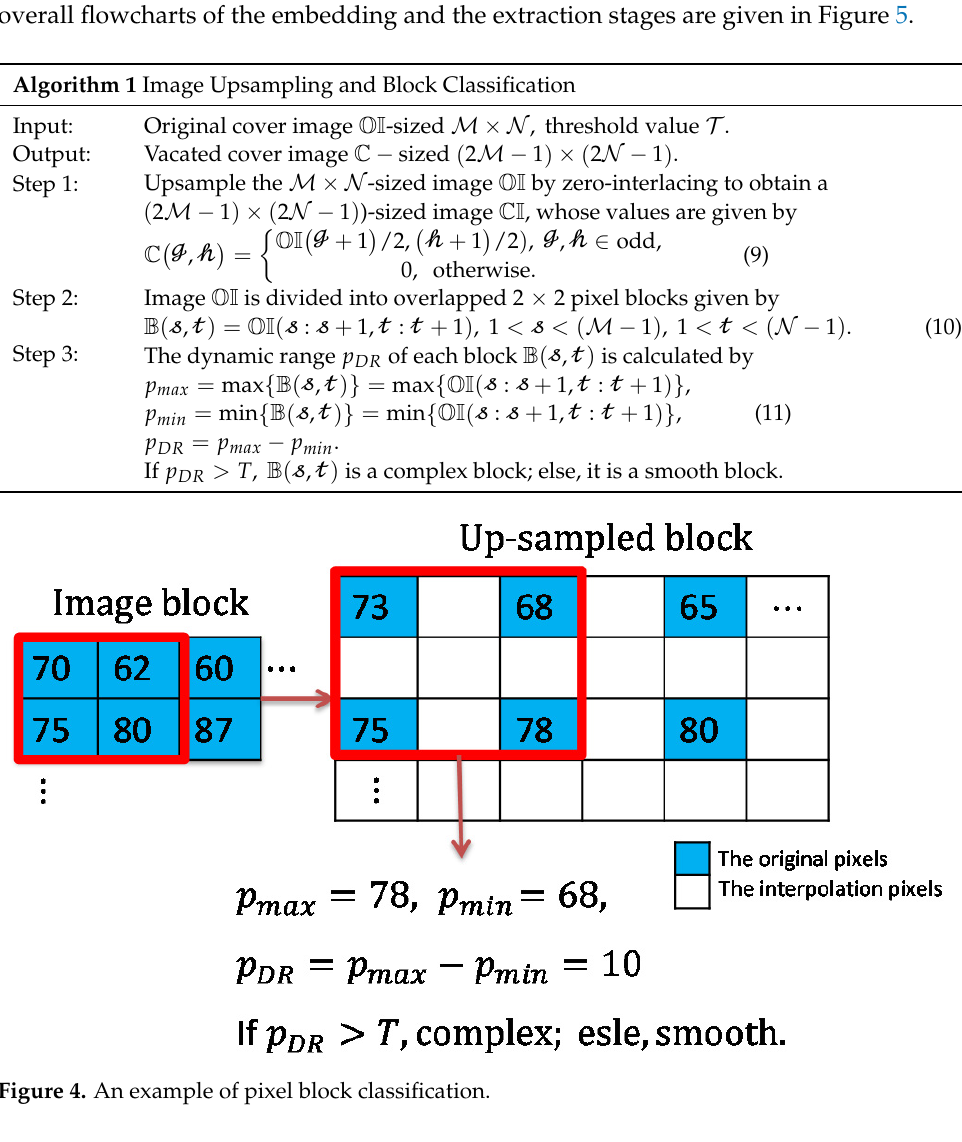
Algorithm 1 Image Upsampling and Block Classification